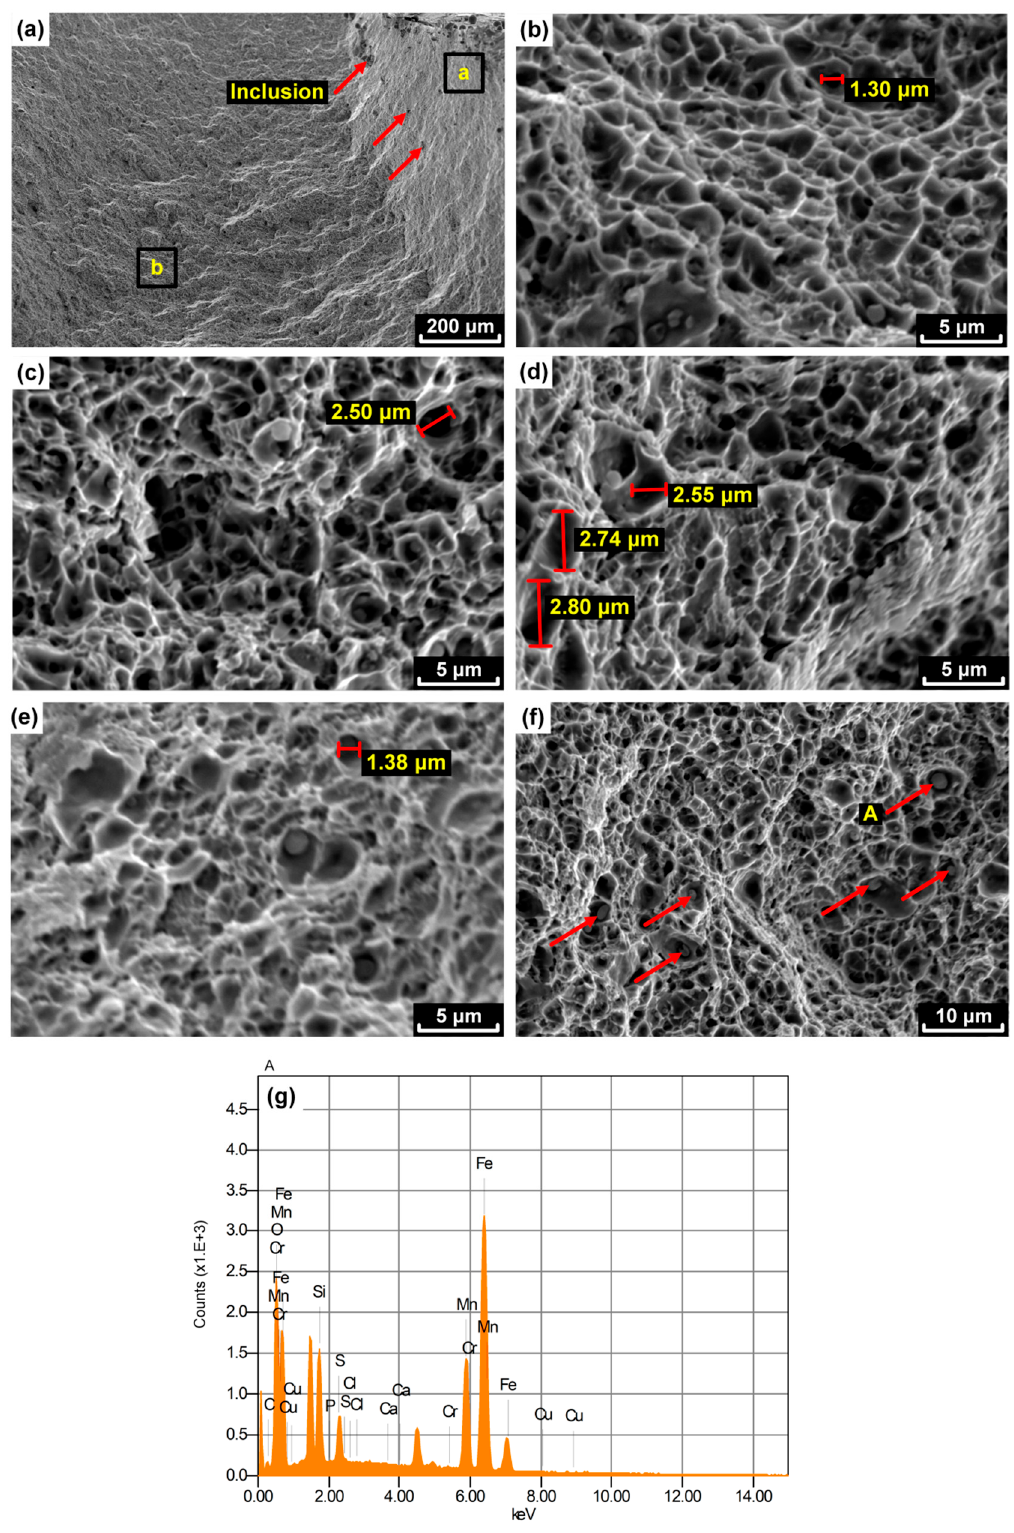
Figure 11. Fractography of tensile samples: ( a ) low magnification, ( b ) bottom, ( c ) middle, ( d ) top, ( e ) vertical, ( f ) energy-dispersive X-ray (EDX) particles, ( g ) energy dispersive spectroscopy (EDS) plot of particle A (at.%).